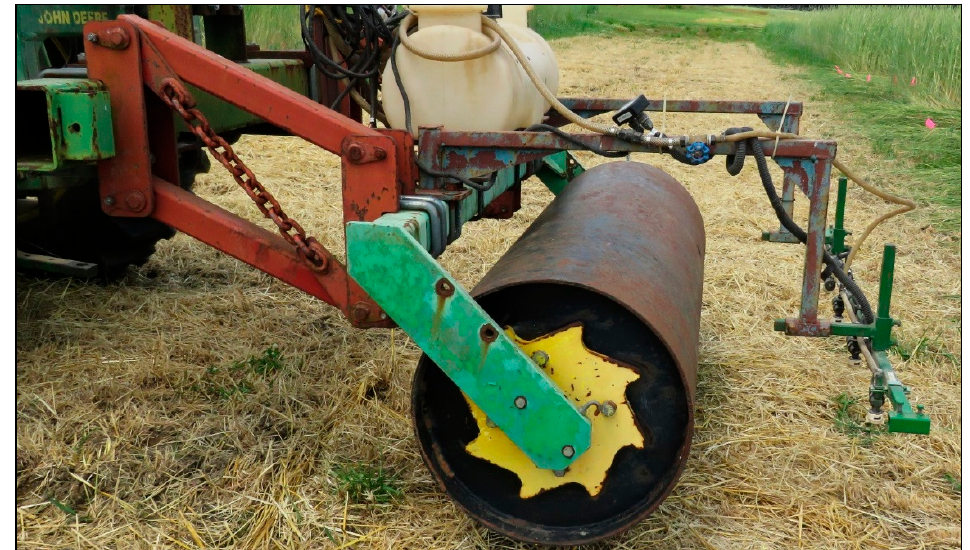
Figure 4. Smooth roller drum without or with herbicide applicator (shown). Table 1. Field activities during the 2015, 2016, and 2017 growing seasons at the E.V Smith Research Center in Central Alabama.